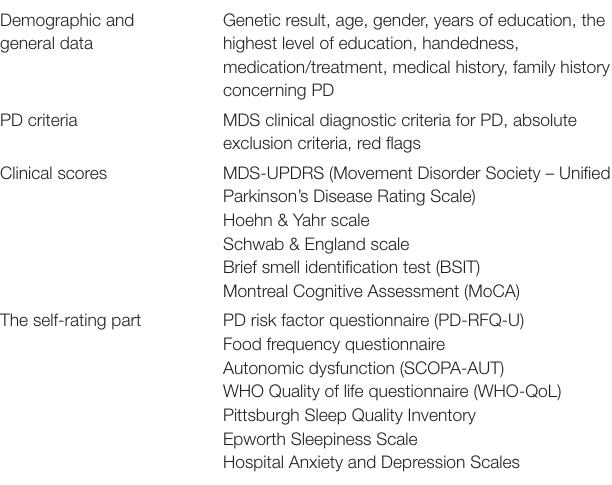
TABLE 1 | Content of the LIPAD electronic case report form. Demographic and general